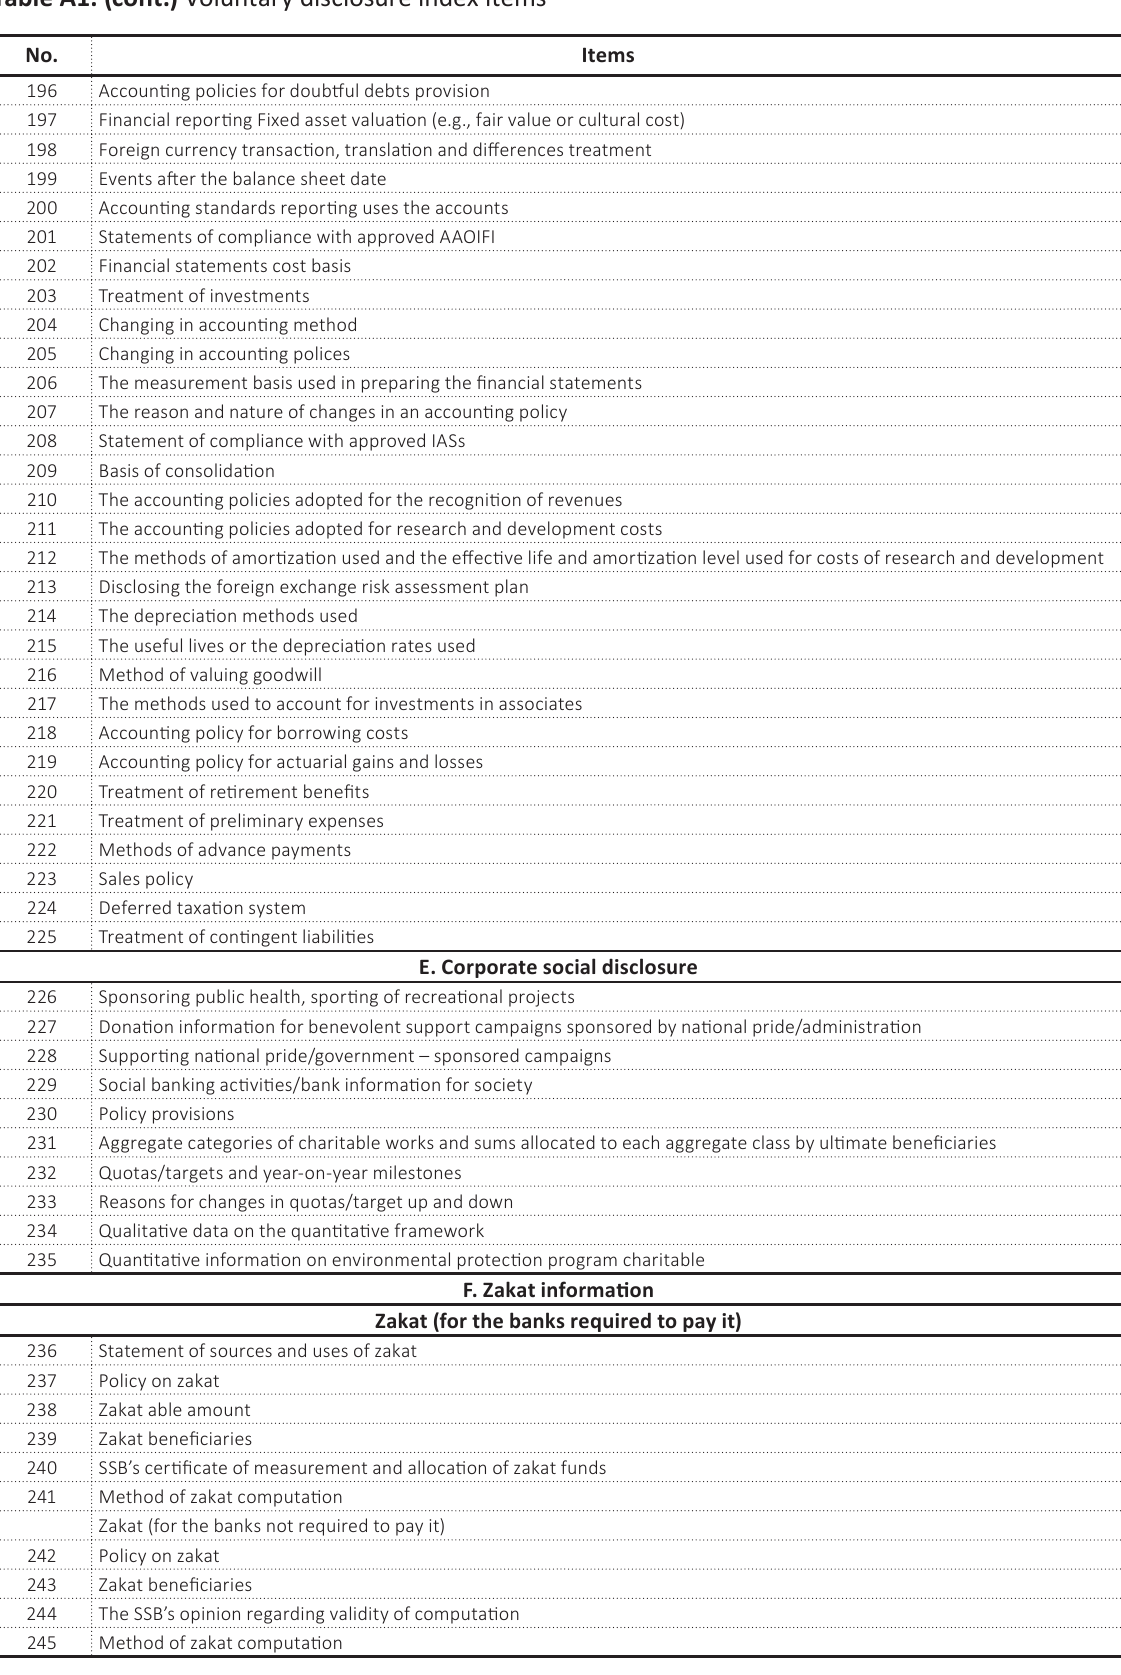
Table A1. (cont.) Voluntary disclosure index